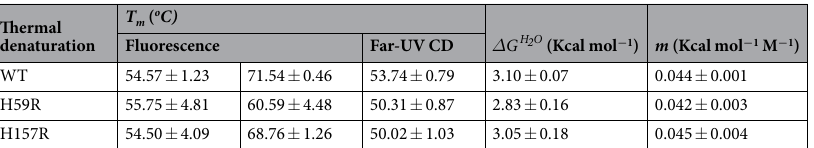
Table 1. Fitted parameters for the thermal unfolding of Pin1-WT, H59R and H157R. T m , the temperature of the denaturation process at the midpoint. Δ G H O 2 , the free energy of unfolding. m , the experimental measure of the dependence of Δ G u on temperature, respectively. + The two-step transitions were used to analyze the unfolding of Pin1-WT, H59R and H157R, from 20 to 60 °C and from 60 to 95